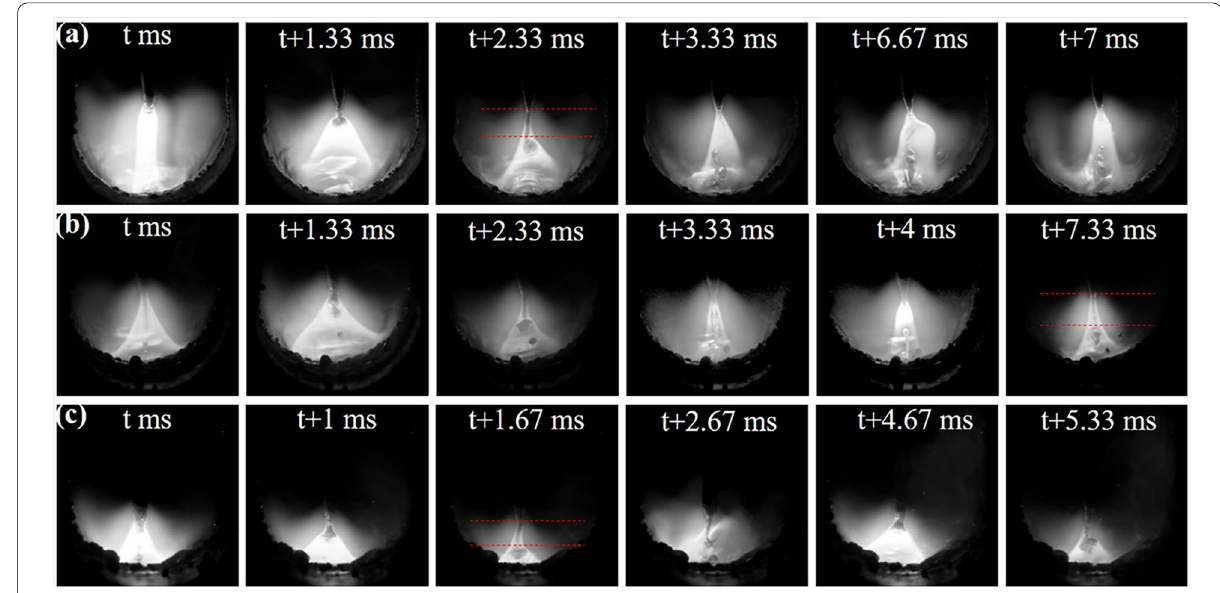
Figure 9 Metal transfer process under shielding of gas mixtures of ( a ) Ar